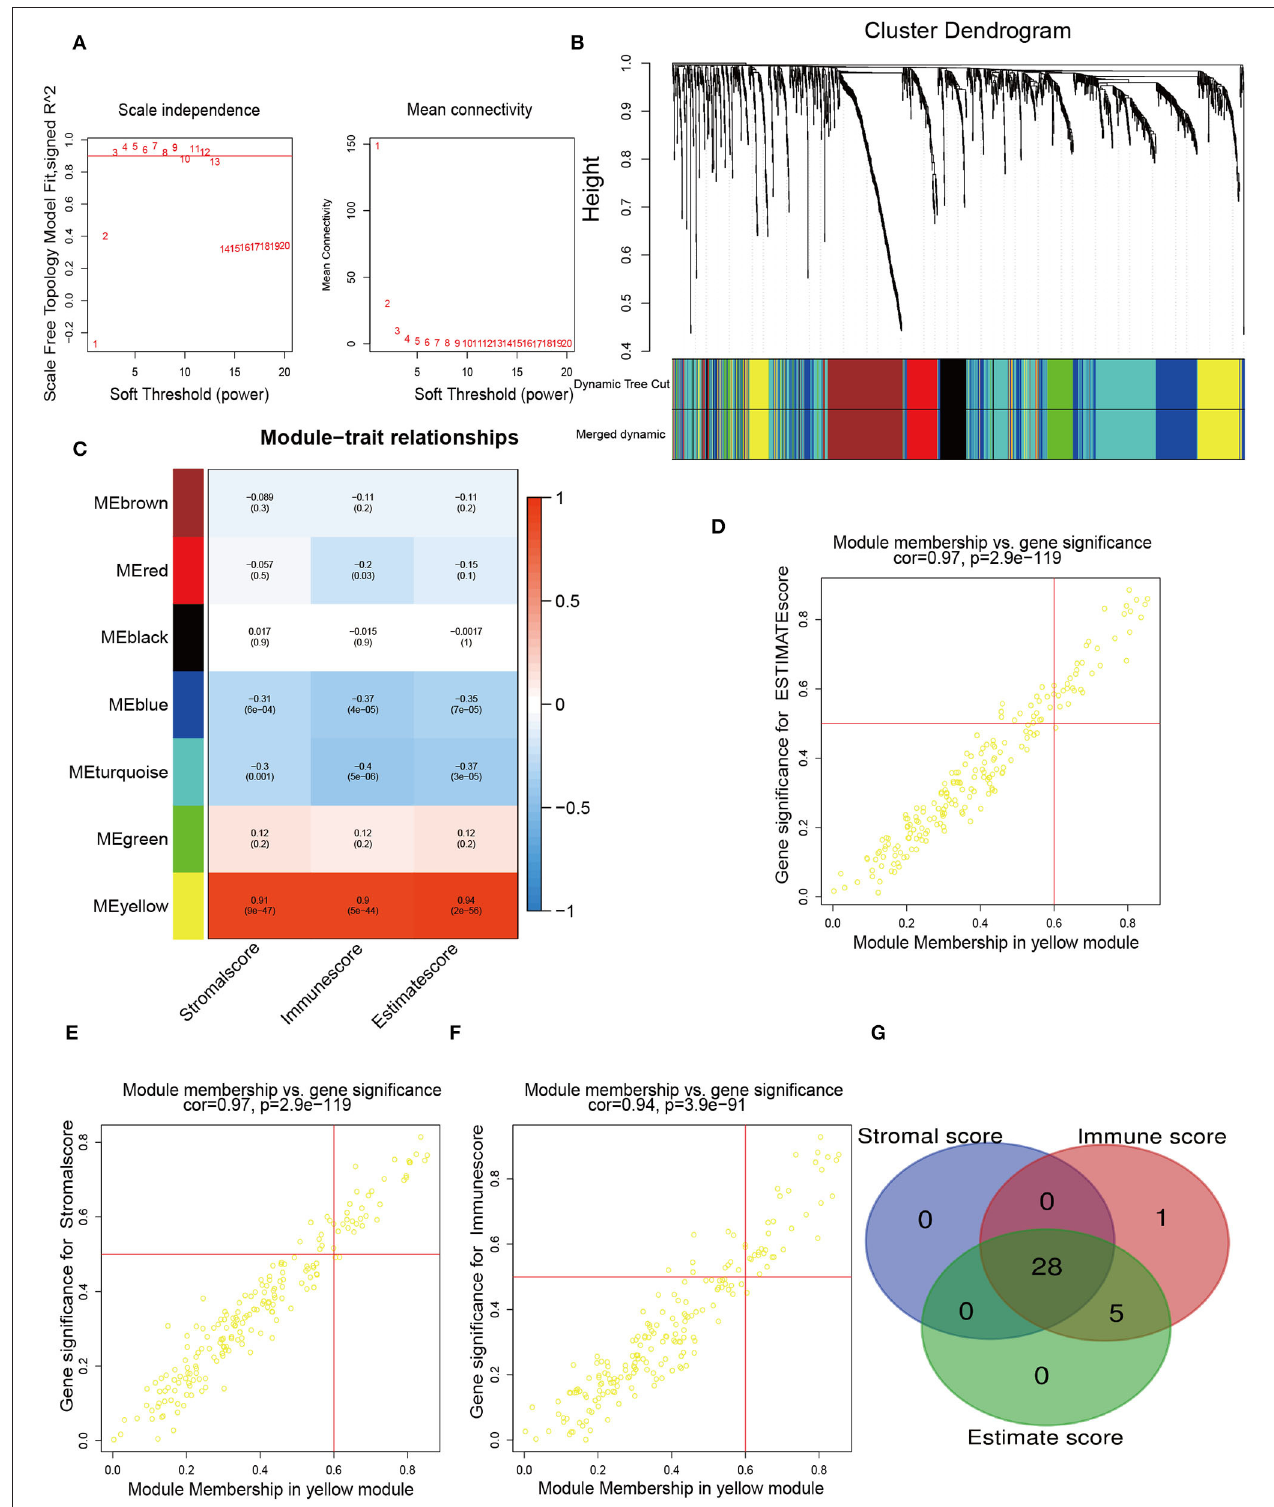
FIGURE 2 | Identification of immune-related hub genes. (A) WGCNA process of immune-related differentially expressed genes with a soft threshold β = 8. (B) Hierarchical clustering dendrogram of the co-expressed genes identified in the modules. Cluster dendrograms have branches corresponding to different gene modules. A clustered dendrogram has one gene corresponding to each leaf. (C) Relevance of gene modules to clinical traits. For each cell, the correlation coefficient